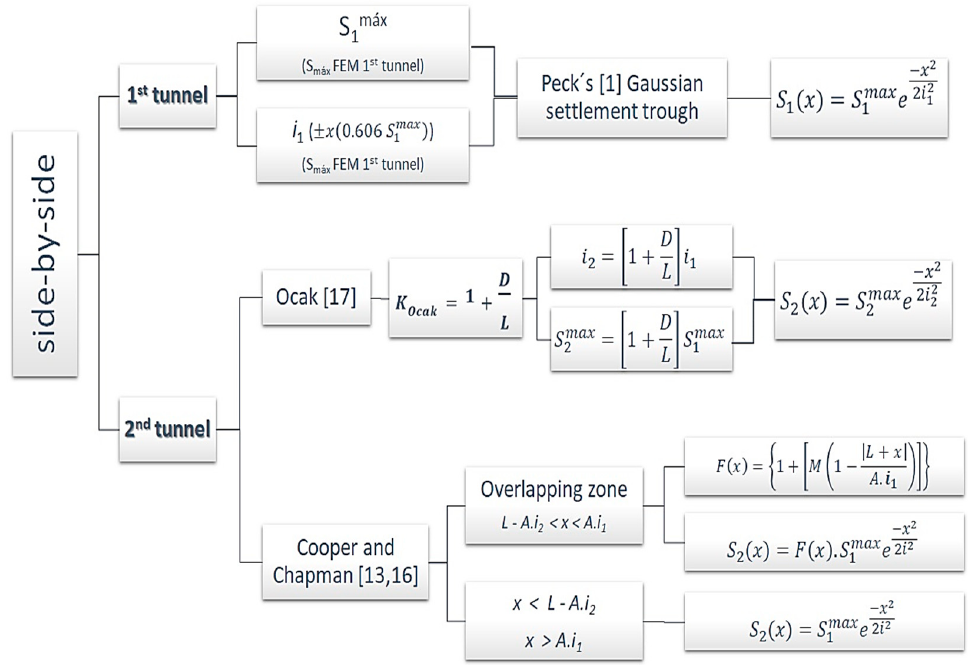
Figure 4. Semi-empirical settlement trough calculation procedure.